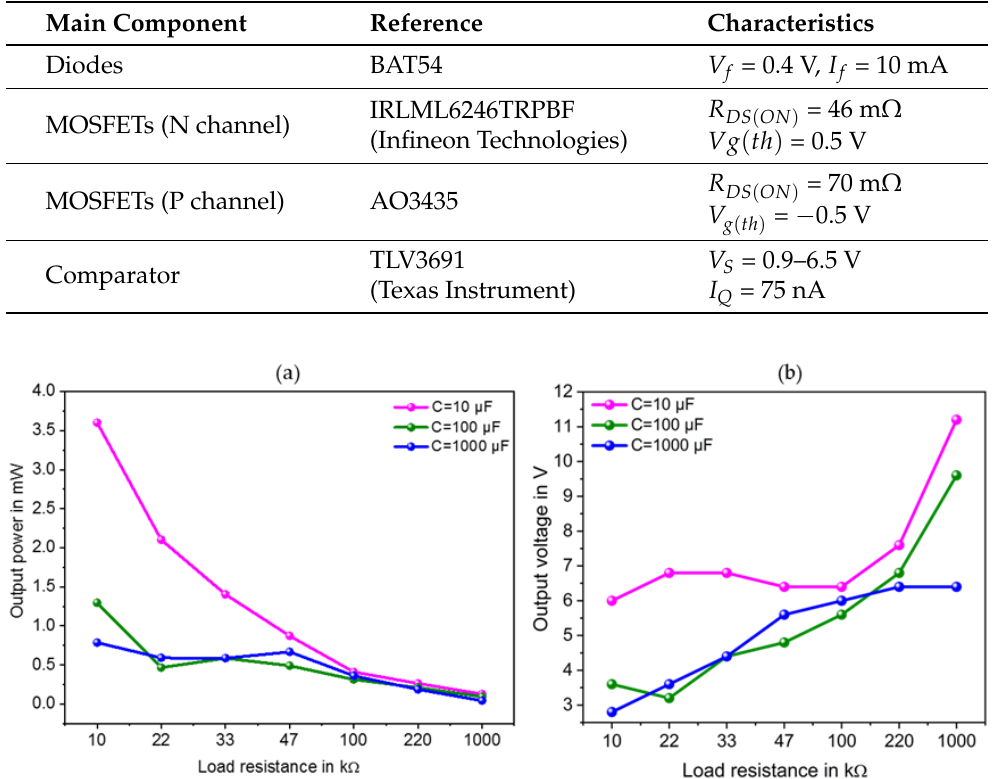
Table 4. Specifications of hardware components.